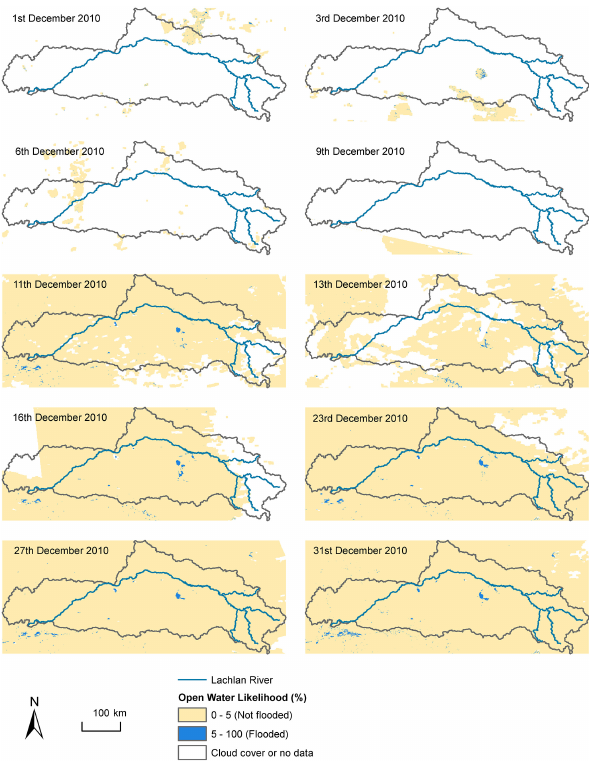
Fig. 4. OWL in the Lachlan catchment during flooding in Decem- ber 2010. Flooded areas detected by MODIS data are indicated in dark blue. Cloud coverage and no data signal are indicated in white. Null data due to no satellite signal (indicated by straight line bound- aries between data and no data) are present on 9 and 16 December. Although there was a large interruption of the data set just prior to and during the start of the flooding (1–9 December), very few areas of standing water were observed immediately after the rainfall event (post-11 December).